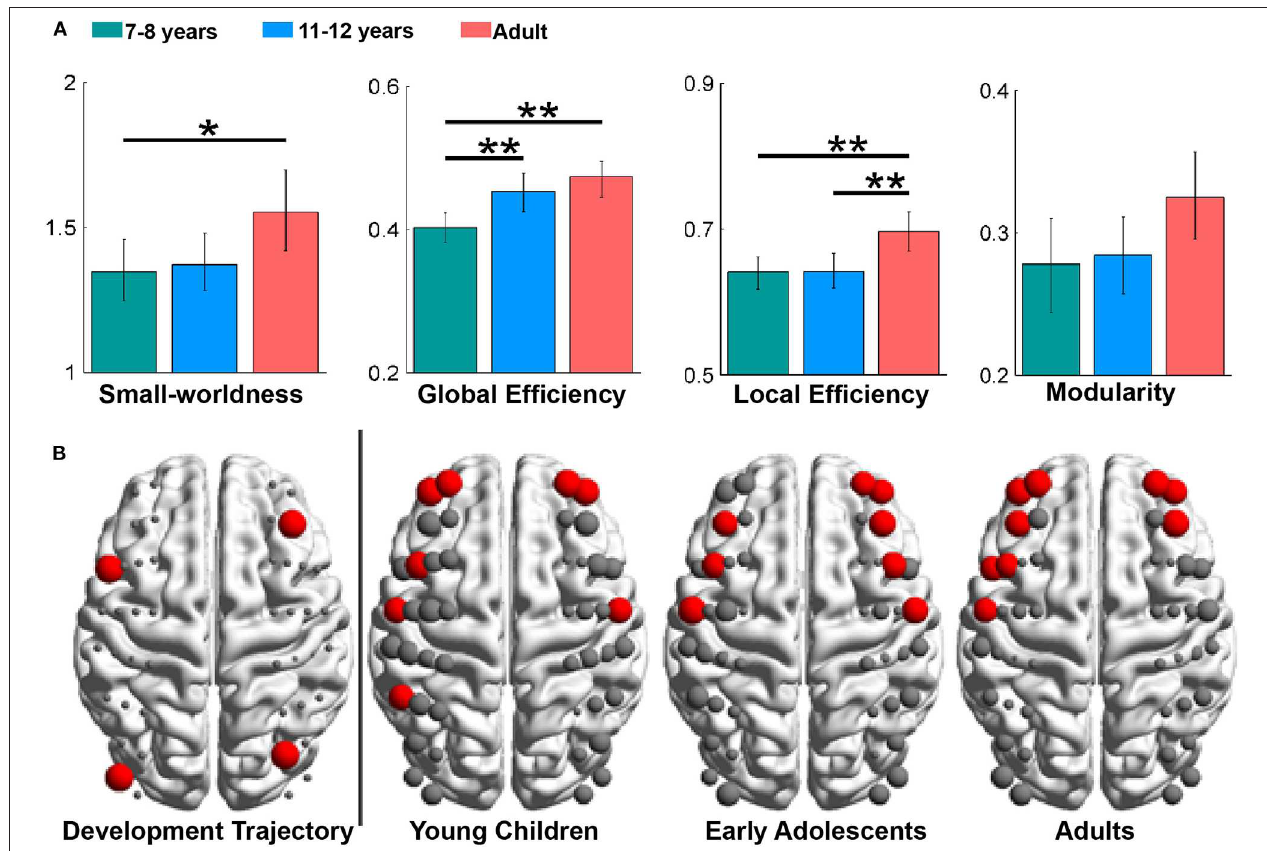
FIGURE 5 | Developmental trajectories of brain network topologies and asymmetry. (A) Group differences in the global network metrics, with significance indicated by asterisks (* p < 0.05, ** p < 0.01). (B) The developmental trajectory (left) and hub distributions (right). In the developmental trajectory, nodes exhibiting age-related increases in nodal efficiency are shown in red. In the hub distributions, hubs are also shown in red, and the node size represents the values in the nodal properties. These figures are adapted from Cai et al. (2018) under an Attribution-Non-Commercial-NoDerivatives 4.0 International License (CC BY-NC-ND 4.0, https://